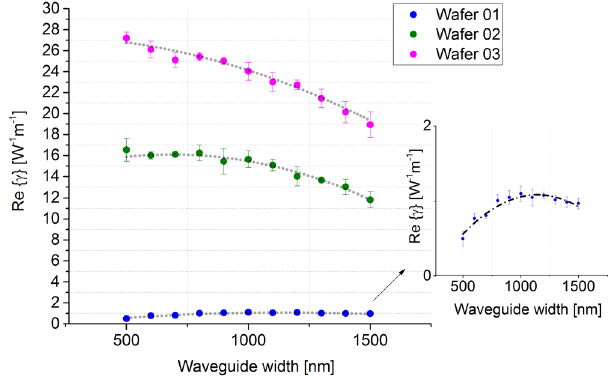
Figure 6. Main panel: Re{ γ } measured for each waveguide configuration, on each silicon nitride composition. Inset: zoom of Wafer 01 Re{ γ } measurements, to clearly show the extent of the error bars.